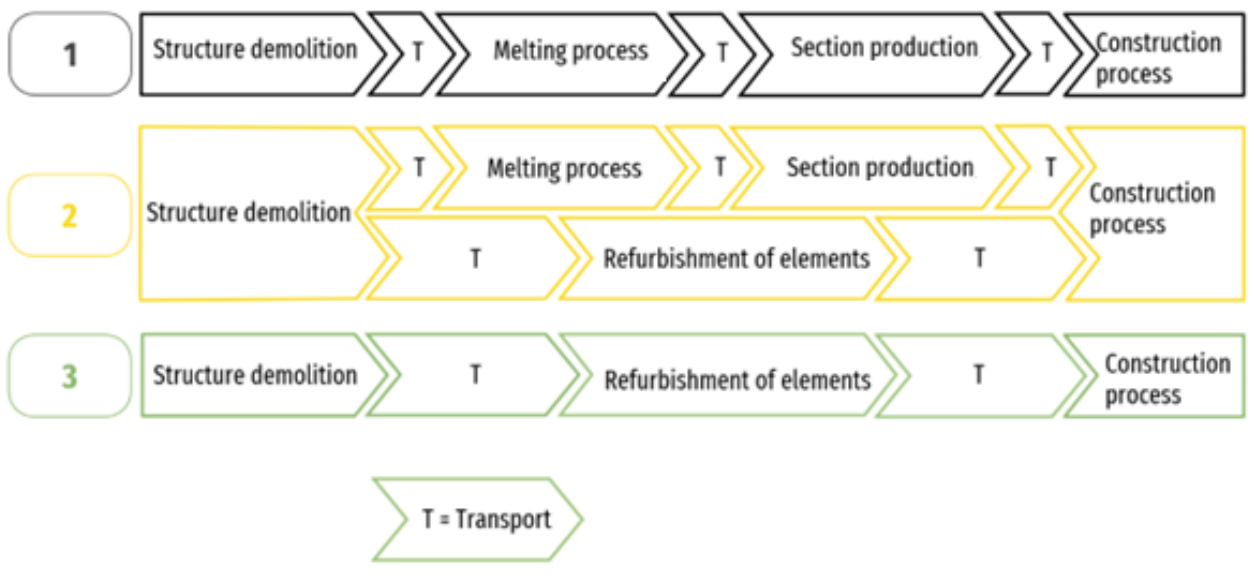
Figure 2. Diagrams of the analyzed